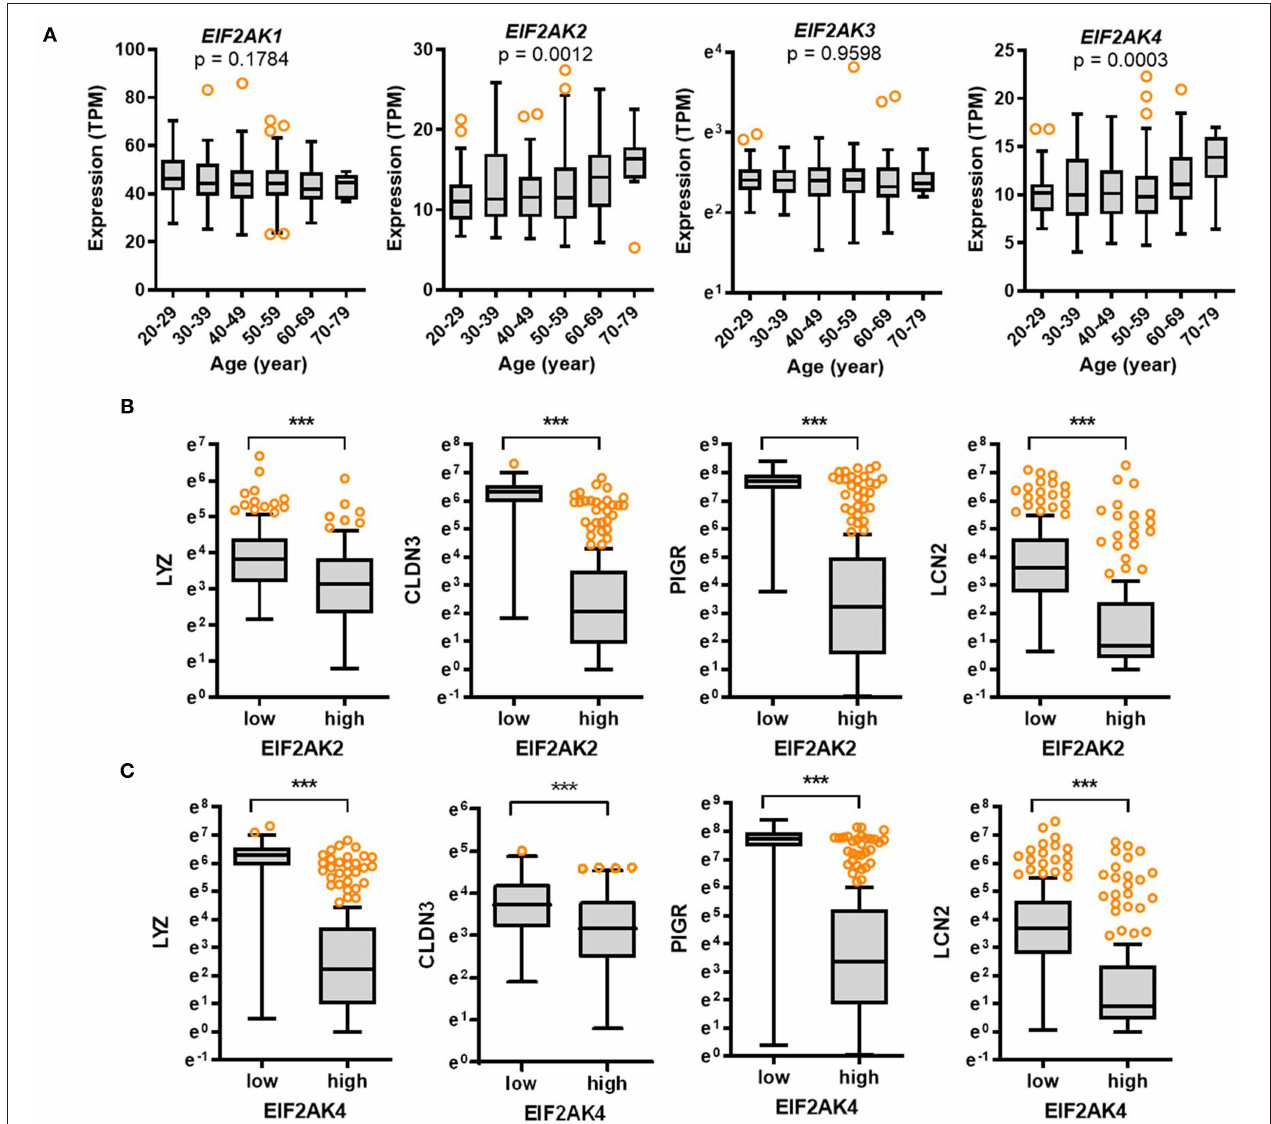
FIGURE 4 | Expression of eIF2 α kinases and their association with gut defense biomarkers with age. (A) Results are depicted as box-and-whisker plots (Turkey) for expression of eIF2 α kinases ( EIF2AK1, EIF2AK2, EIF2AK3, or EIF2AK4 ) in normal mucosal intestinal tissues (GTEx dataset v8). Values are presented as transcripts per million (TPM). Statistical significance of the expression variation with age is illustrated on the top of each plot (Kruskal–Wallis test). (B,C) Considering the EIF2AK2 (B) or EIF2AK4 (C) levels, we selected the 150 highest and 150 lowest level samples, which were further evaluated based on LYZ, CLDN3, PIGR , and LCN2 levels. Values are presented as natural logarithm of TPM. Asterisks (*) indicate significant differences from the low expression group (*** p <